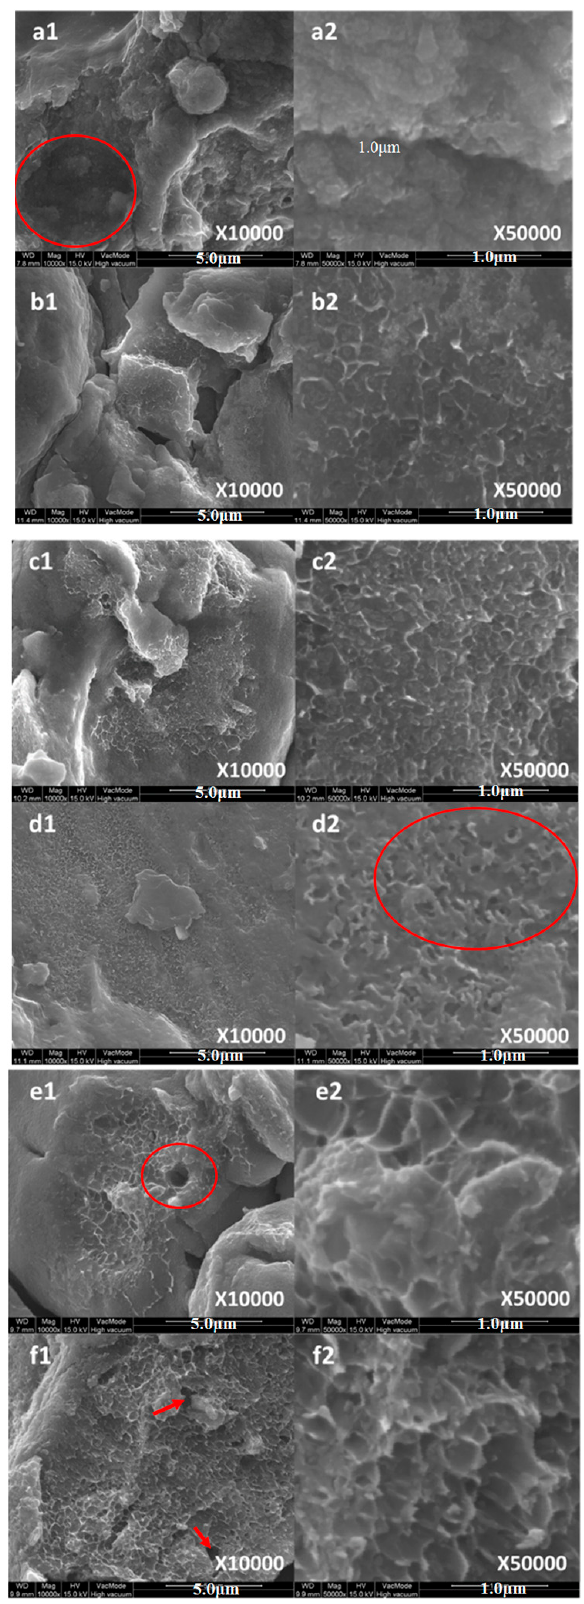
Figure 11. SEM micrographs of fracture cross section by low magnification and high magnification in (allow refer to dimple) ( a1 , a2 : Al6061; b1 , b2 : 1 vol %; c1 , c2 : 3 vol %; d1 , d2 : 5 vol %; e1 , e2 : 7 vol %, and; f1 , f2 : 10 vol %).